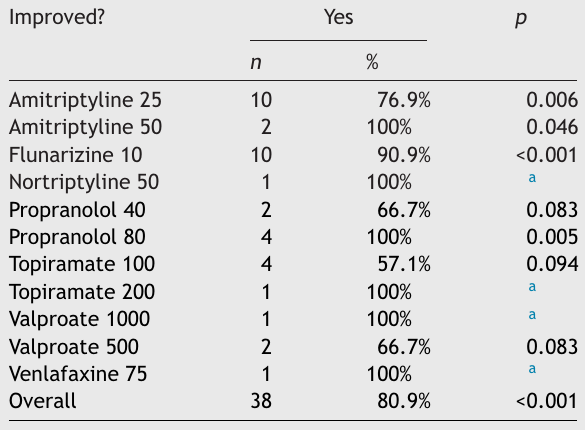
Clinical improvement in patients with VM.